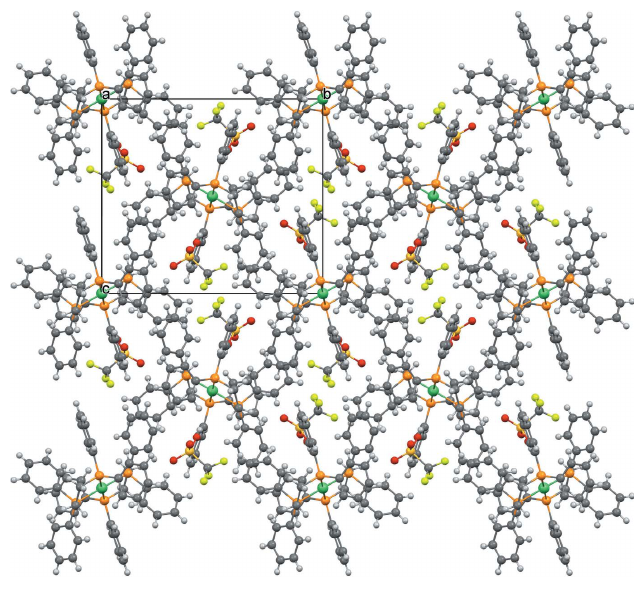
Figure 4 Packing view of 1 at 100 K along the a